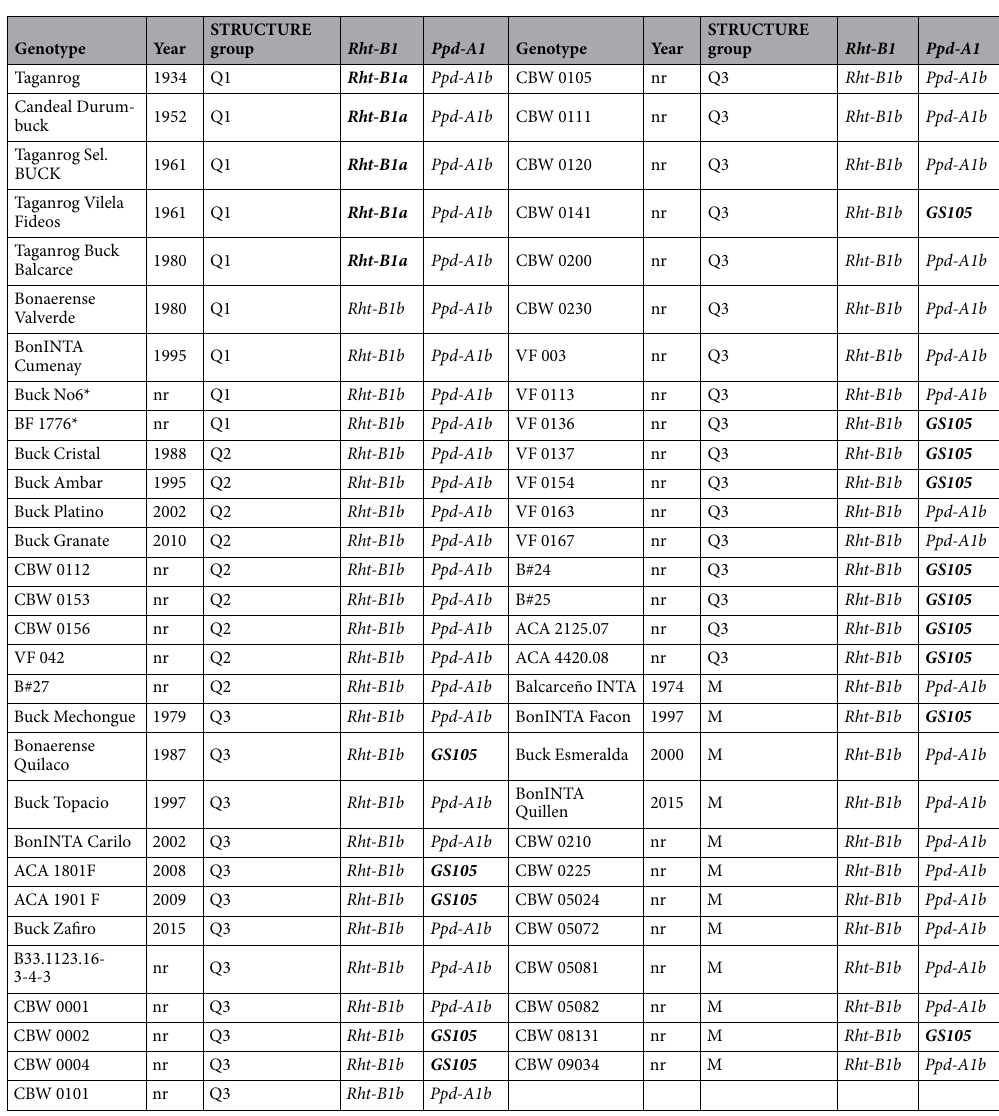
Table 1. Name, year of release, group assigned by STRU CTU RE and the Rht-B1 and Ppd-A1 allelic variants of the durum wheat genotypes analyzed in this study. The year of release of genotypes was taken from Roncallo et al. 36 . nr not released. *Only two not released genotypes were developed before 1980. GS105 deletion in Ppd- A1 gene is also named as Ppd-A1a